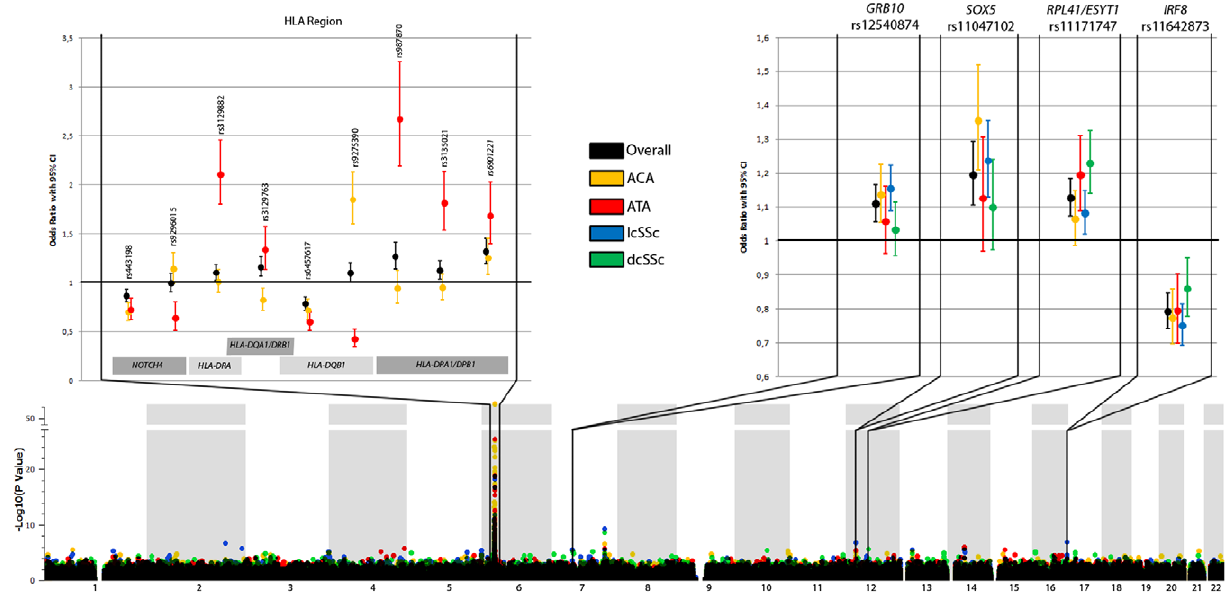
Figure 1. New loci associated with subphenotypes of SSc. The lower part shows the Manhattan Plot with corrected P values of the GWAS cohorts. The upper part shows the ORs and the 95% CI interval of the novel associated regions in the GWAS cohorts (HLA region, left panel) and all cohorts (non-HLA loci, right panel) for the overall analysis and each subphenotype considered in the study. (Note: the ORs and CIs on the forest plot do not exactly correspond to the numbers in Table 1 and Table 2. Table 1 and Table 2 shows marginal effects of these SNPs while this figure presents ORs and CIs after the adjustment for the other SNPs claimed as independent for that phenotype).